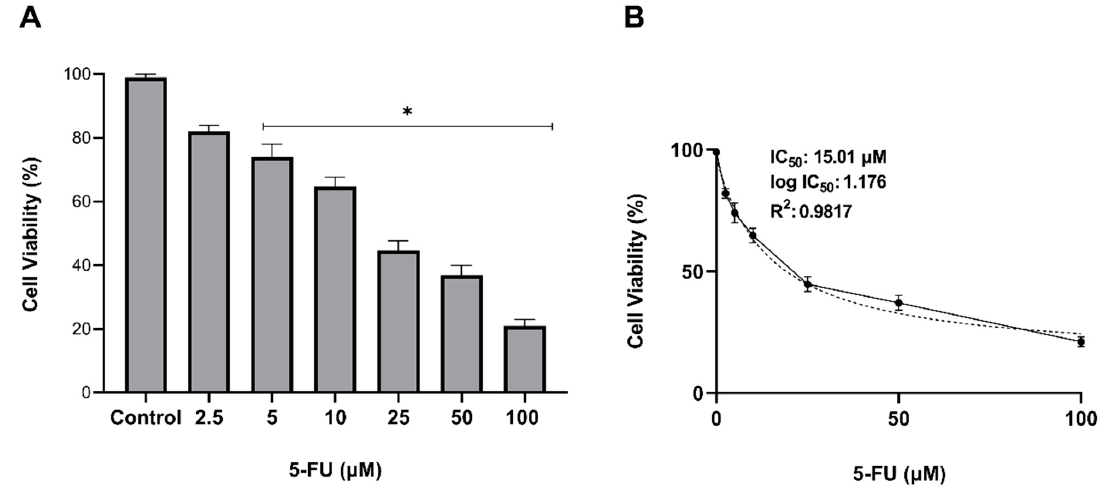
Figure 4. Determination of the antiproliferative effect of 5-FU on AGS cells. To assess the IC50 of 5-FU, cells were exposed to 2.5, 5, 10, 25, 50, and 100 µ M 5FU for 24 h, and cell viability was evaluated by WST-1 assay. The percentage of cell viability relative to untreated (control) cells ( A ) and IC50 value of 5-FU ( B ) were presented in the graphs. Error bars represent the standard deviation of the mean (* p <